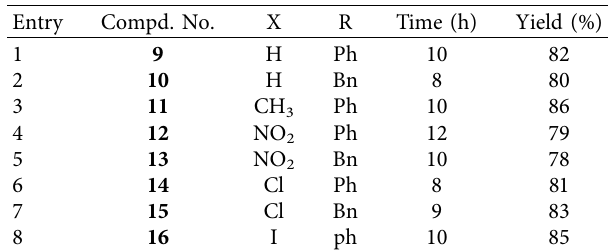
Table 1: Reaction of quinazolinthione with sodamide in methanol. Entry Compd.